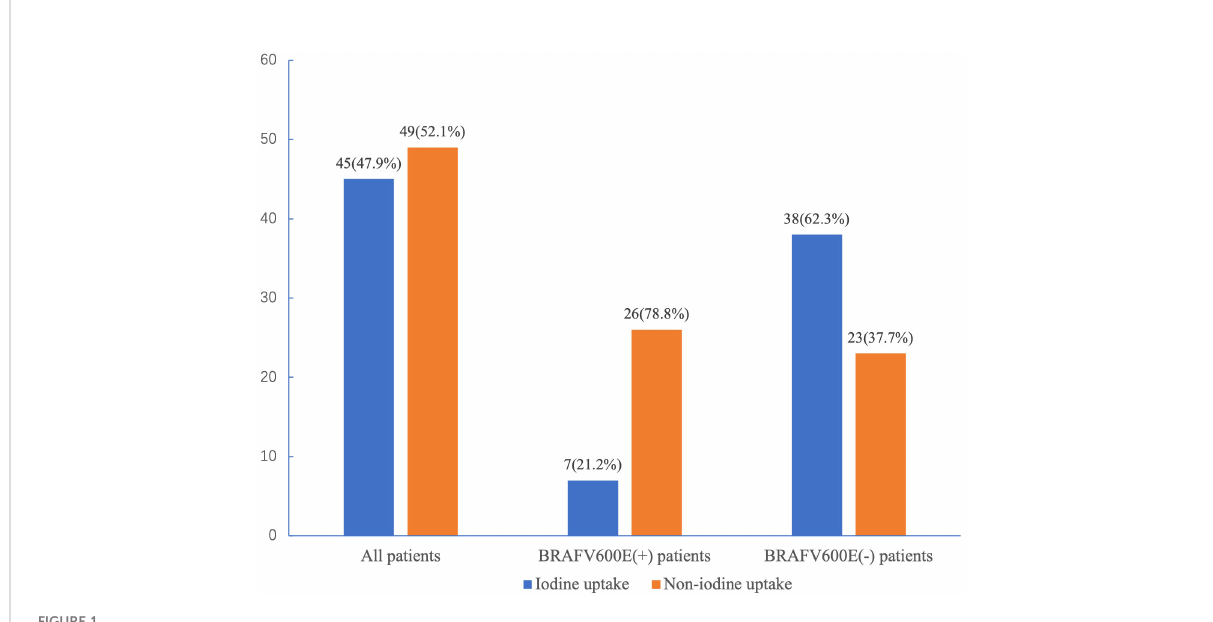
FIGURE 1 BRAF V600E mutation status and radioiodine avidity status in all